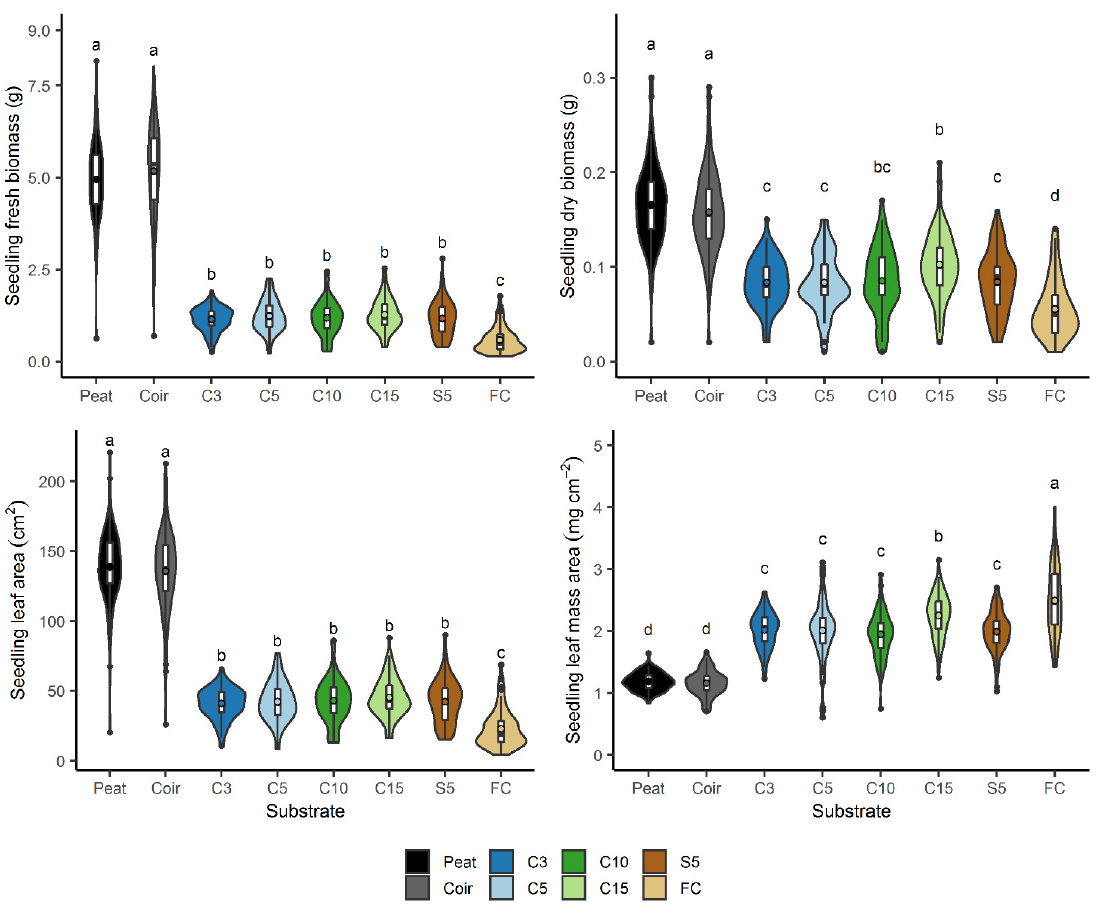
Figure 10. Seedling growth on peat, coir, and six processed miscanthus substrates: seedling fresh biomass, dry biomass, leaf area and leaf mass area. The violin plot represents the data distribution of 72 single seedlings at each substrate (4 replicates × 18 seedlings). The boxplot inside represents median, interquartile ranges and mean value as point. The width of the violin represents the number of value in each range. Different small letters indicate statistically significant differences in means among substrates (Tukey’s HSD, p ≤ 0.05, mean ± standard deviation, n = 72). Miscanthus × giganteus was harvested with a forage harvester (FC, field-chips), then processed with a mechanical fraying facility through a 5-mm screen (S5, shreds) or a hammermill with screen sizes of 15, 10, 5, and 3 mm (C15, C10, C5, and C3, chips).